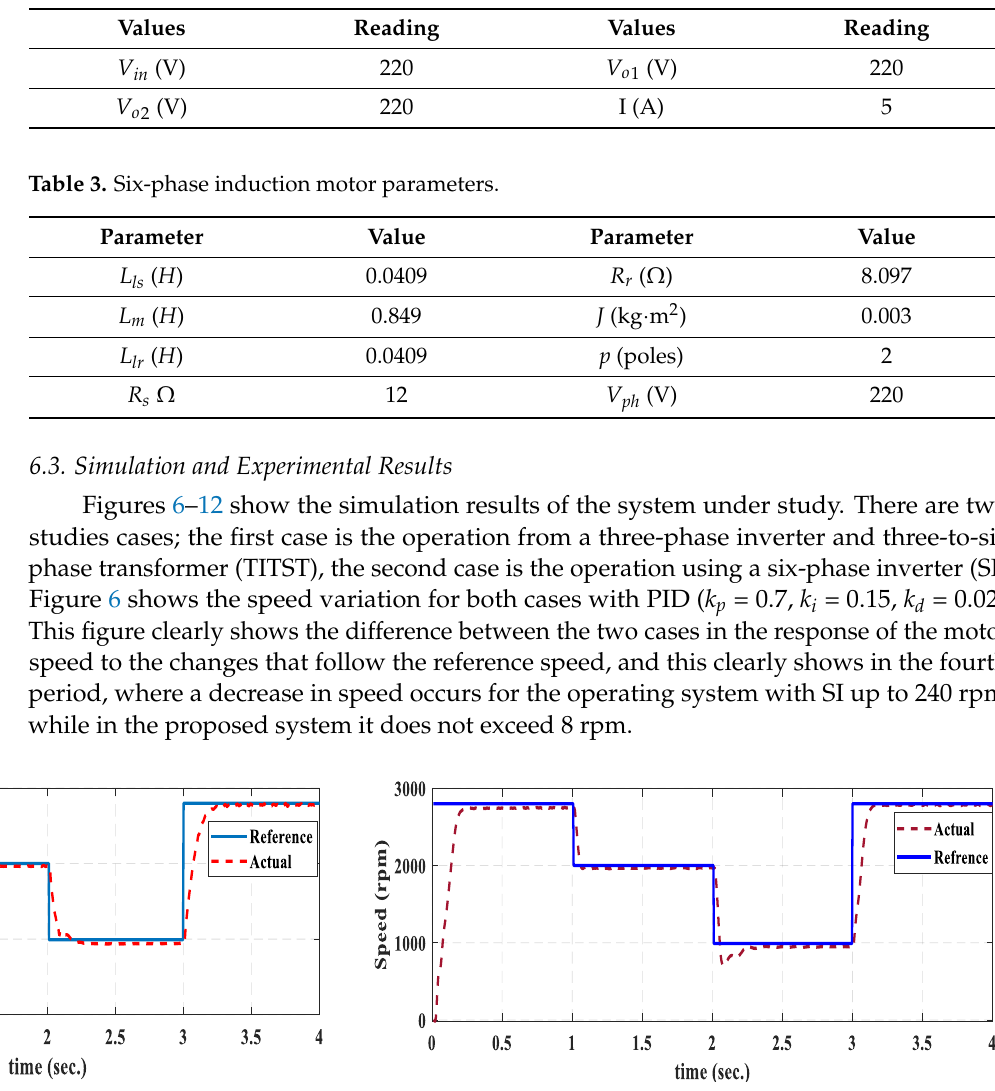
Figure 7. Pump torque–time characteristics with PID. Figures 8 and 9 show the simulation of harmonic contents of voltage and current total harmonic distortion THD, respectively. The operation using TITST is better and gives a smaller value of total harmonic distortion. Figure 10 represents the phase voltage of different periods of operation for the two cases.